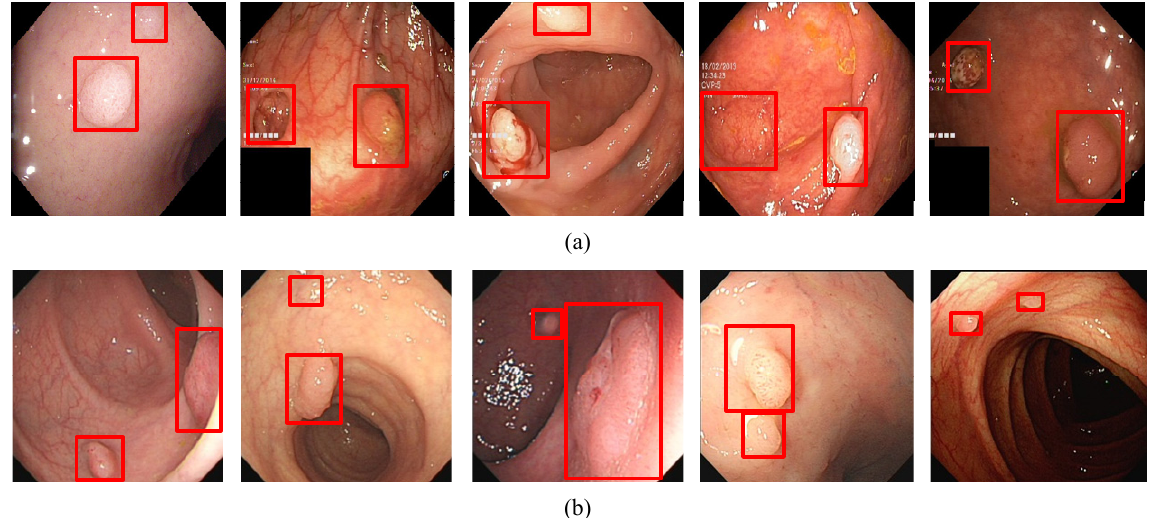
Figure 9. ( a ) A subset of the detection results of multiple target polyps in Kvasir-SEG data set. ( b ) A subset of the detection results of multiple target polyps in WCY data set. The red squares in the figure are the bounding boxes of the polyps.